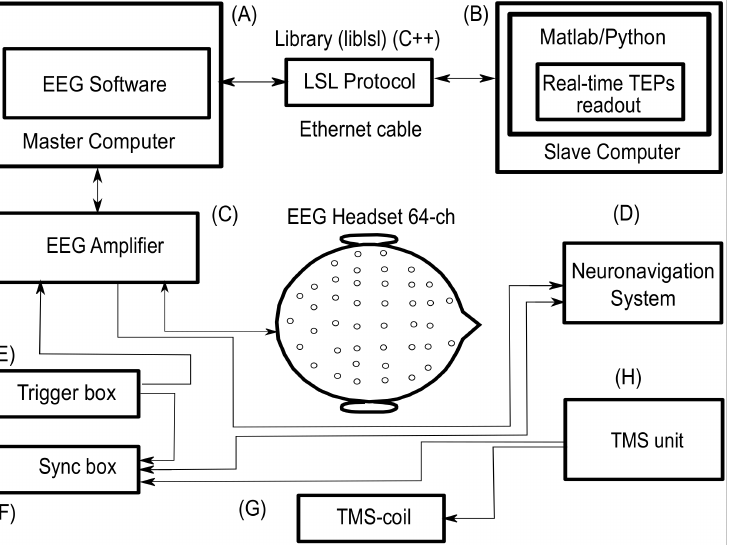
Figure 2. TMS-EEG laboratory layout block diagram. Our proposed TMS-EEG laboratory set-up is based on continuous “dialogue” between each device in this setting. Here, ( A ) represents the Master Laboratory PC with EEG recording software; ( B ) a Slave PC to run a customized software suite for real-time TEPs readout; ( C ) represents a TMS compatible EEG amplifier system; and ( D ) the Neuronavigation Systems. In ( E ) we illustrate a trigger device to jitter Inter-Pulse-Interval (IPI) during TMS tasks; whereas in ( F ) we illustrate a synchronization box (see Figure 1) to time neural information across the device; and ( G ) represents a TMS coil. In ( H ), the TMS unit can be used like a Master device to synchronize other tools. Generally, noise masking and trigger software are running on ( A ) or ( B ). The black arrows highlight the direction of communication, from right to